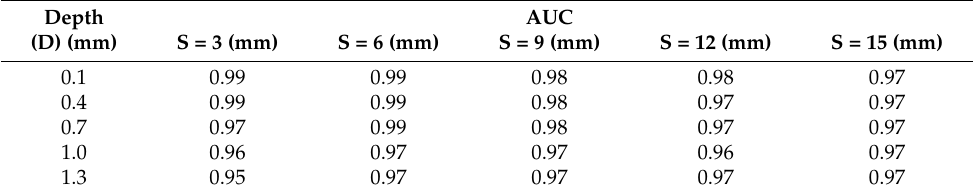
Table 4. AUC indicator for simulated thermal sequence sum-type synthetic